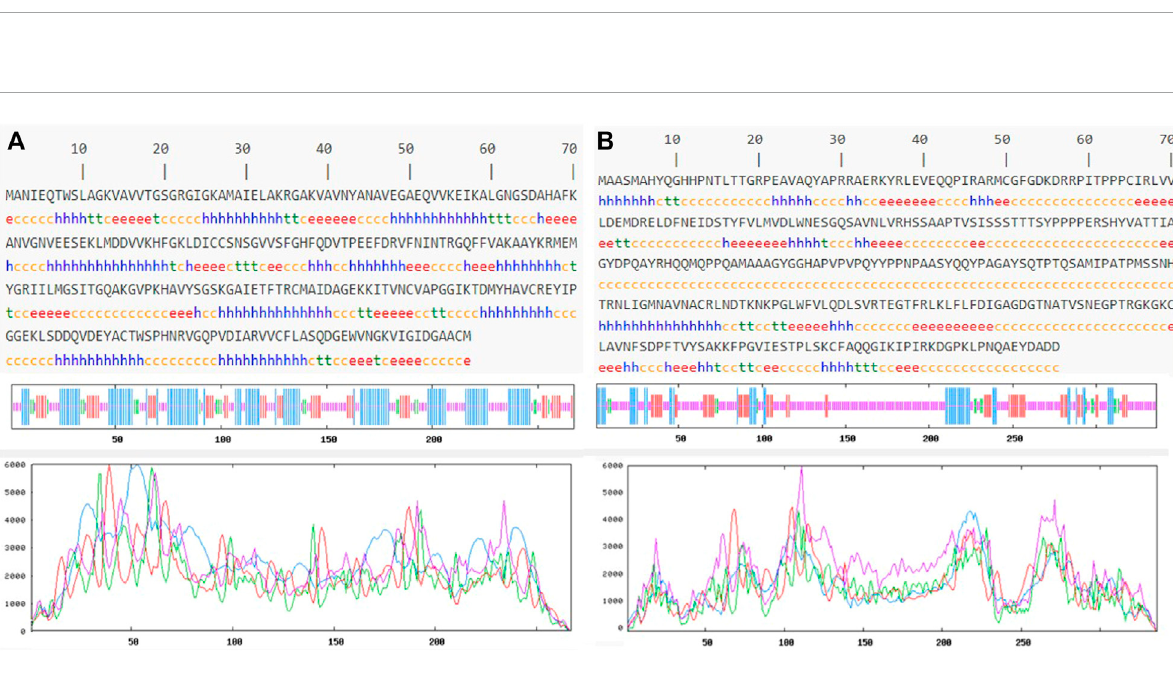
FIGURE 4 Predicted secondary structure validation of THR (A) and VelB (B) proteins of C. lunata using SOPMA. The blue line represents α -helices, red colour represents the extended strand, green colour represents β -turn, and magenta colour represents the random coil in graphical representation. The X -axis represents position of the amino acid; the Y -axis shows the score for each predicted